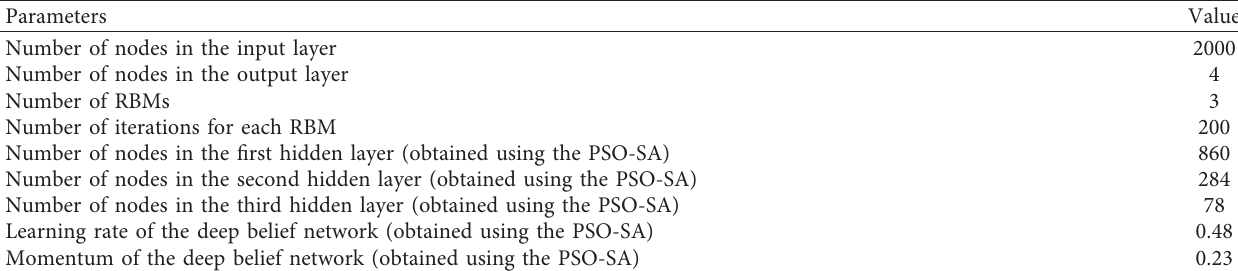
Table 3: Optimization parameters of the